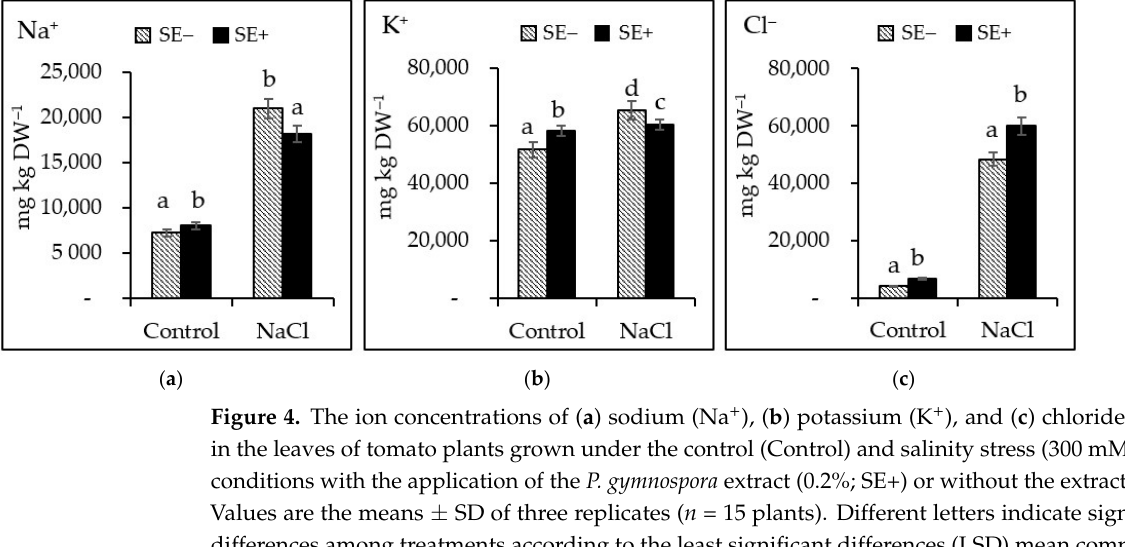
Figure 4. The ion concentrations of ( a ) sodium (Na + ), ( b ) potassium (K + ), and ( c ) chlorides (Cl − ) in the leaves of tomato plants grown under the control (Control) and salinity stress (300 mM NaCl) conditions with the application of the P. gymnospora extract (0.2%; SE+) or without the extract (SE − ). Values are the means ± SD of three replicates ( n = 15 plants). Different letters indicate significant differences among treatments according to the least significant differences (LSD) mean comparison test ( p ≤ 0.001). The application of SE at 0.2% in plants grown under salinity stress conditions led to a significant ( p ≤ 0.005) increase in the Na + and Cl - concentrations (2.2- and 8.9-fold, re- spectively). Moreover, the K + concentration increased by 1.1-fold compared to that of the control, although this increase was not significant (Figure 4b).